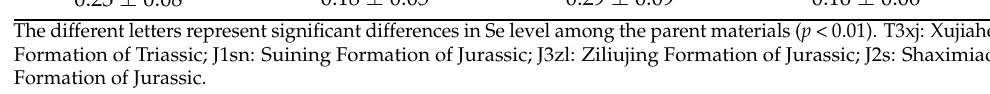
Table 4. Soil Se content (mean ± standard deviation, mg/kg) in different land uses ( n = 2804).